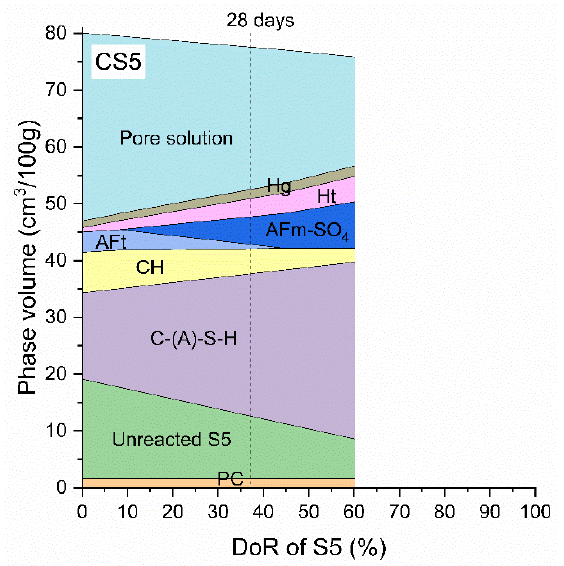
Figure 17. Modelled phase volume changes of slag blended pastes CS1, CS3 and CS5 as a function of DoR of slag by GEMS. Ht—hydrotalcite, Hg—iron bearing hydrogarnet, AFm-SO 4 —monosulfate, AFt—ettringite, CH—portlandite. Table 7. Modelled phase contents of slag blended pastes corresponding to the obtained 28-day DoR of slag (cm 3 /100g).